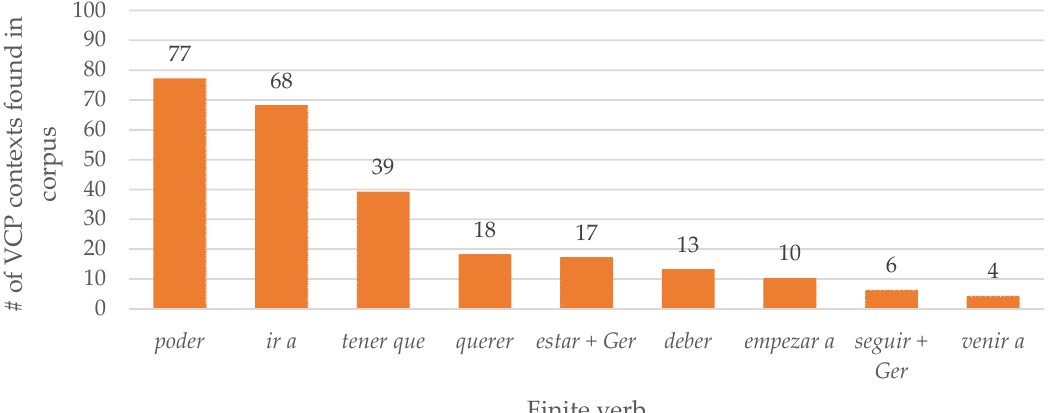
Figure 1. Distribution of all (N = 252) variable clitic placement tokens according to the finite verb in the corpus of Argentine Spanish. Note: In all these variable constructions, the finite verb listed is followed by an infinitive, except in the two cases signaled with “+ Ger” where the non-finite verb is a gerund.